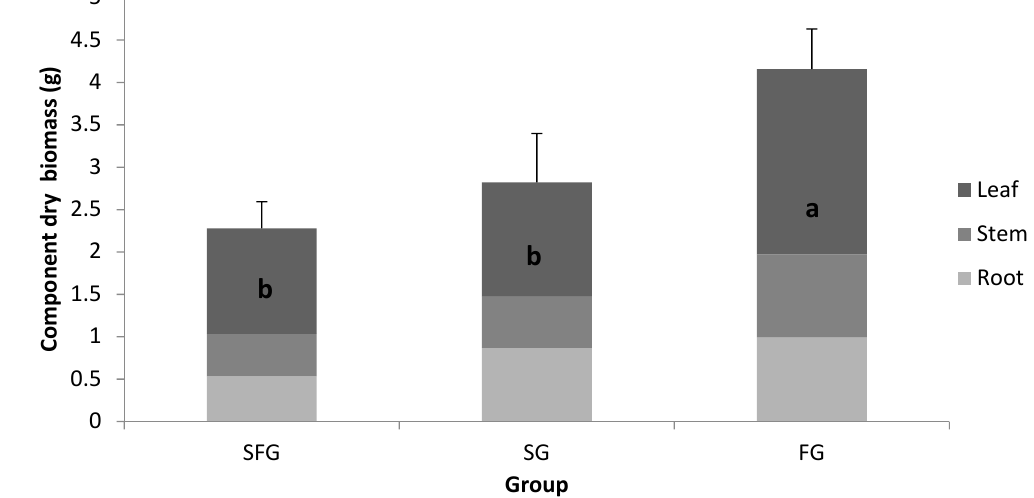
by different letters at p ≤ 0.05.